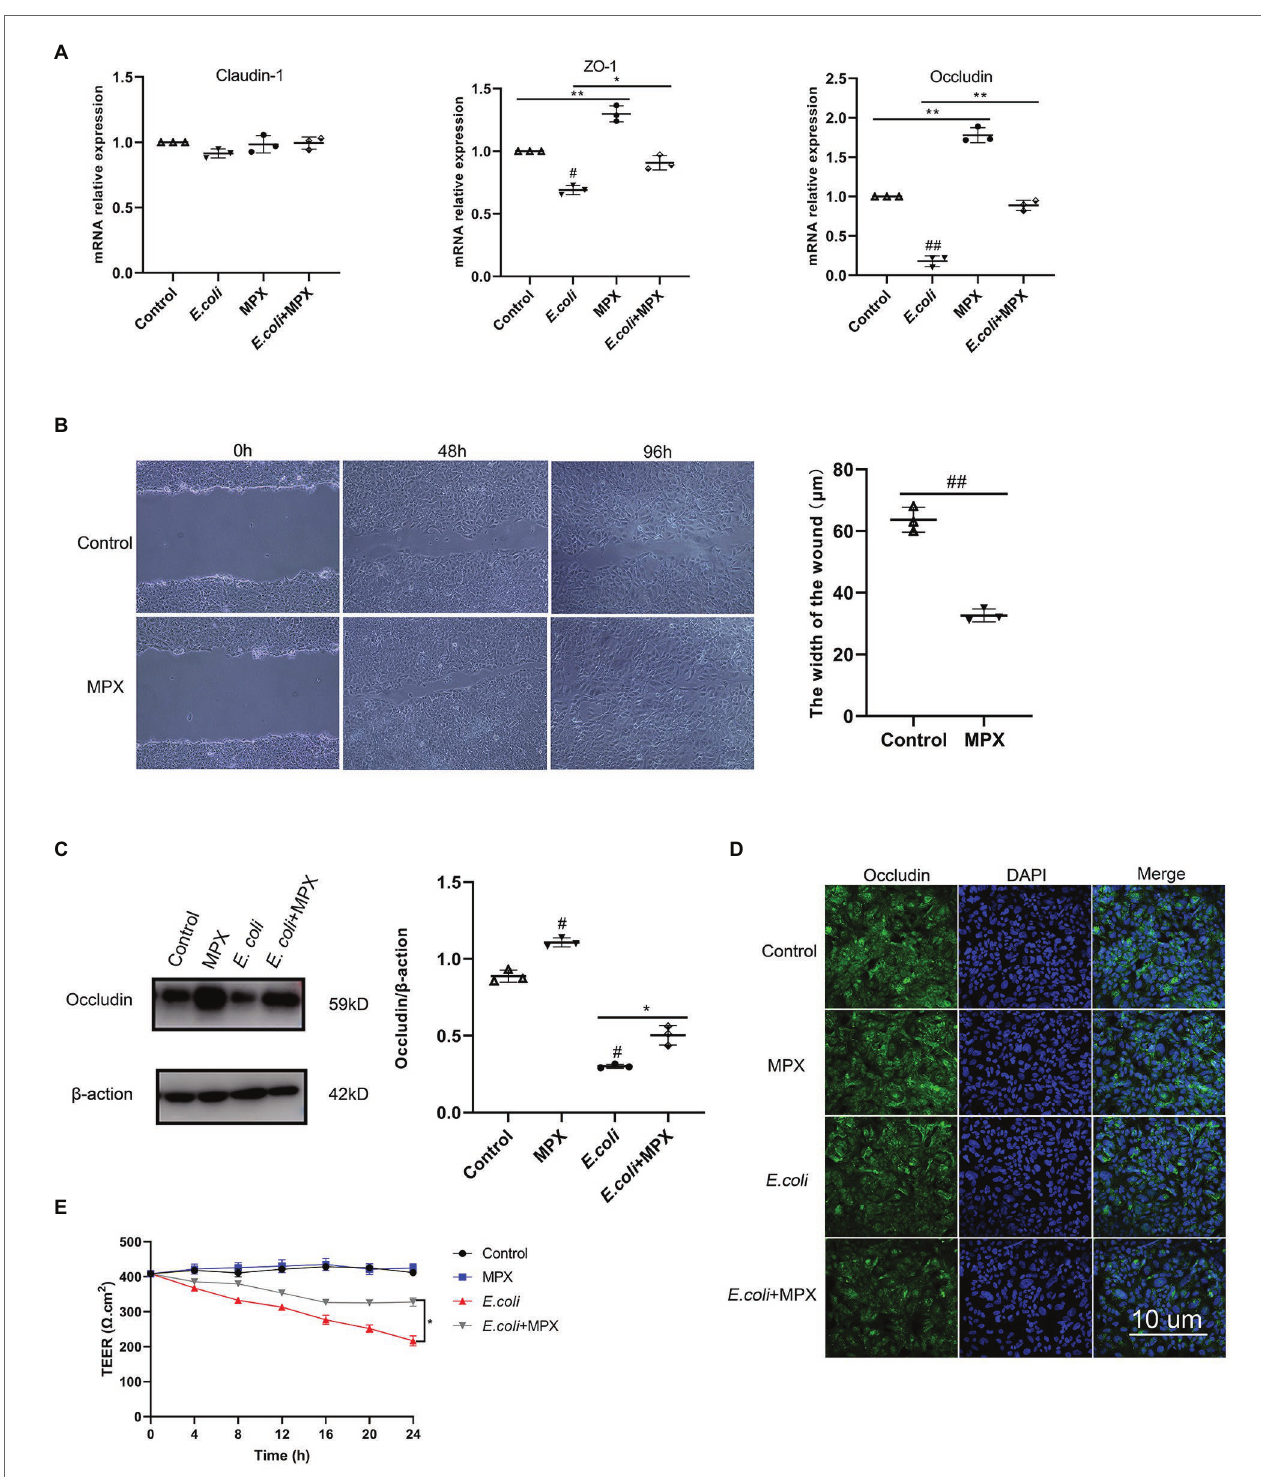
FIGURE 2 | MPX enhances IPEC-J2 cell barrier function. (A) The E. coli -induced mRNA expression of ZO-1, occludin and claudin-1 in IPEC-J2 cells after treatment with MPX. (B) IPEC-J2 cells were incubated with medium alone or MPX (10 μg/mL) in a wound healing assay. Images were obtained at 0 h, 48 h and 96 h, and the wound width was measured at 48 h. (C) The E. coli -induced protein level of occludin in IPEC-J2 cells after pretreatment with MPX was determined by western blotting. (D) The effect of MPX on the expression of occludin in IPEC-J2 cells was assessed by confocal laser microscopy. (E) MPX increases TEER of differentiated IPEC-J2 cells monolayers subjected to E. coli stimulus. Error bars represent mean ± SEM, n = 3. Statistical significance was defined as follows: # P < 0.05; ## P < 0.01; ### P < 0.001 E. coli vs control; * P < 0.05; ** P < 0.01; *** P < 0.001 MPX treatment vs E. coli